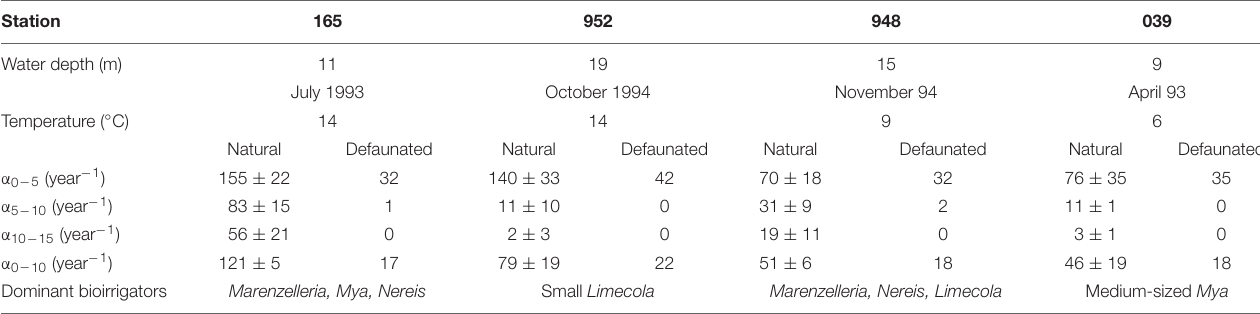
TABLE 2 | Water depth, incubation temperature, and bioirrigation constants calculated for various depth intervals and dominant bioirrigating fauna in the bromide tracer experiments.